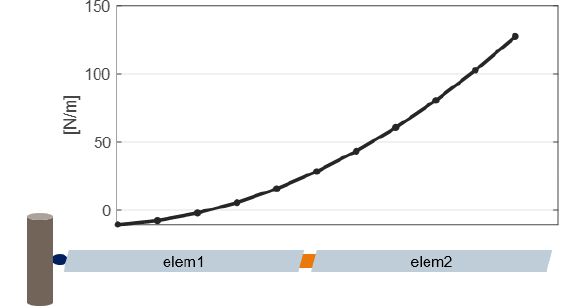
Figure 5. Example of a blade discretized with 2 elements. The lift distribution per unit length is shown